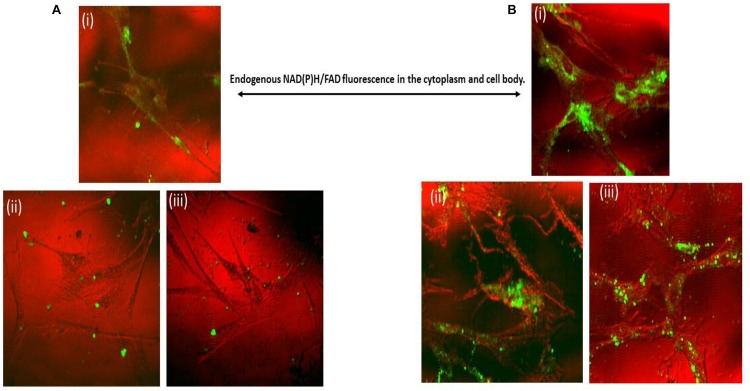
Combined reflectance confocal and two-photon imaging of nanogel uptake by Primary microglial cells at (A): (i) Control; (ii,iii) 6 h treatment; (B): (i) Control; (ii, iii) 24 h treatment of nanogels. Pseudocoloring: Red – confocal (or nearly confocal) reflectance at 780 nm; Green – Two-photon excitation fluorescence (400–633 nm range all together). Average laser power ranging from 5 to 20 mW.